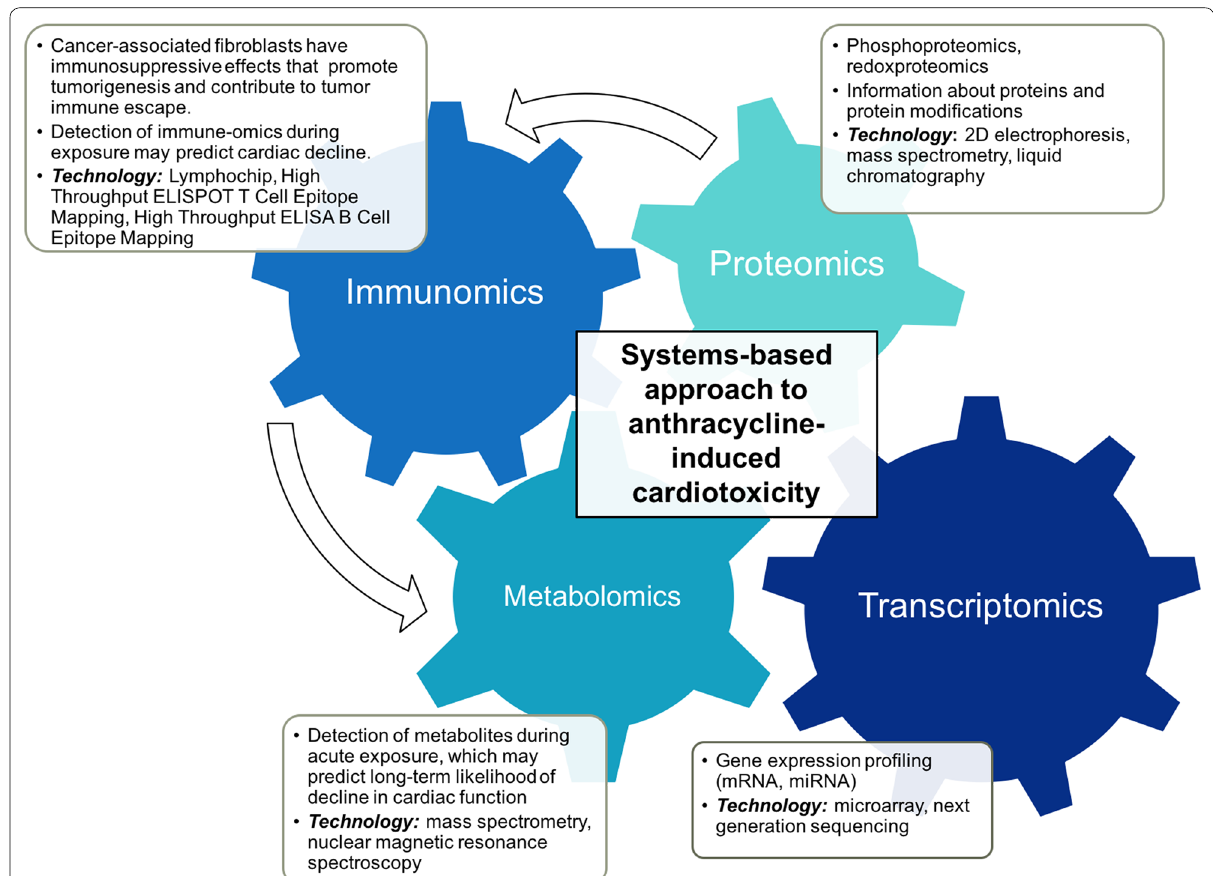
Fig. 2 A systems‑based approach to understanding anthracycline‑induced cardiotoxicity may consist of leveraging –omics technology to identify genomic transcripts ( transcriptomics ), proteins and protein modifications ( proteomics ), and metabolites ( metabolomics ) during acute treatment. Immune‑omics may also be leveraged to study the role of immune interactions, which may alter cardiotoxic response. This panoply of data can be coupled with periodic longer‑term imaging (based on exposure risk) to further identify those at the greatest risk of developing cardiac